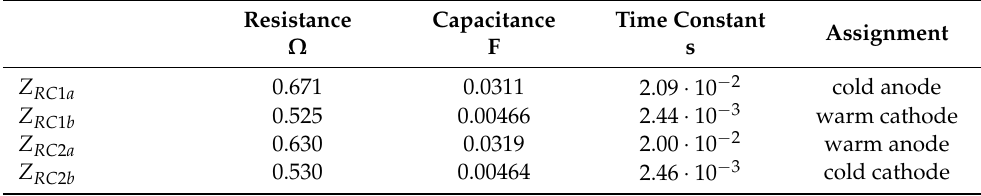
Table 2. Identified resistances and capacitances with the resulting time constants for cell